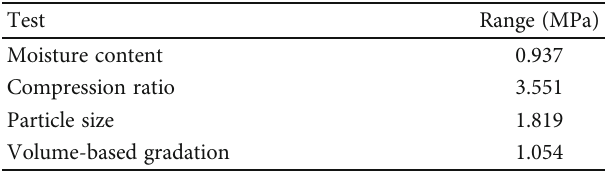
Table 4: Ranges of in fl uence factors of compaction